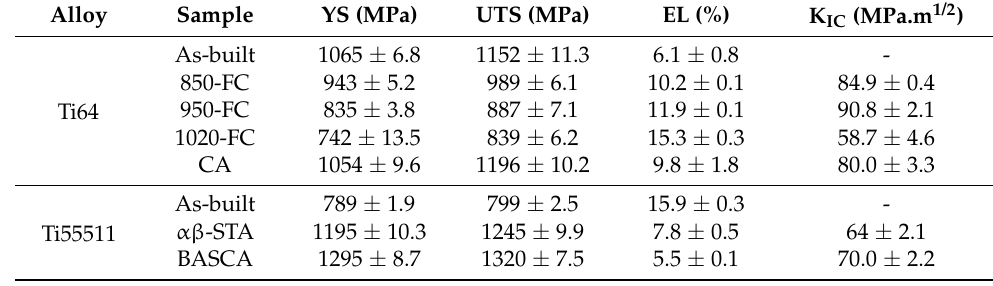
Table 2. The room temperature tensile properties and fracture toughness of Ti64 and Ti55511.